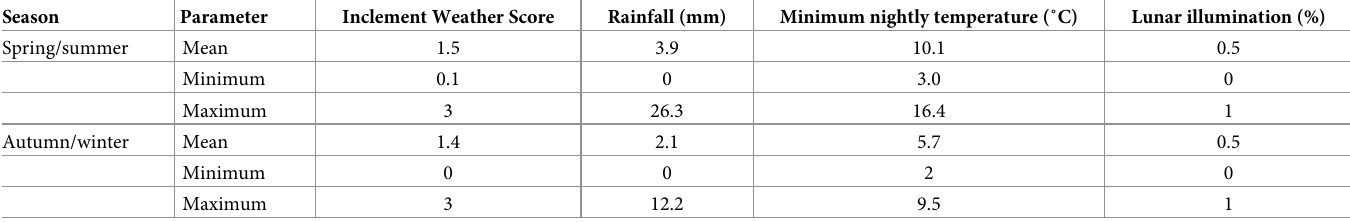
Table 1. The nightly mean, minimum and maximum values for inclement weather score, and climatic variables for the spring/summer and autumn/winter sam- pling periods, that were included in the dynamic occupancy models for Yellow-bellied Glider vocalisations. Season